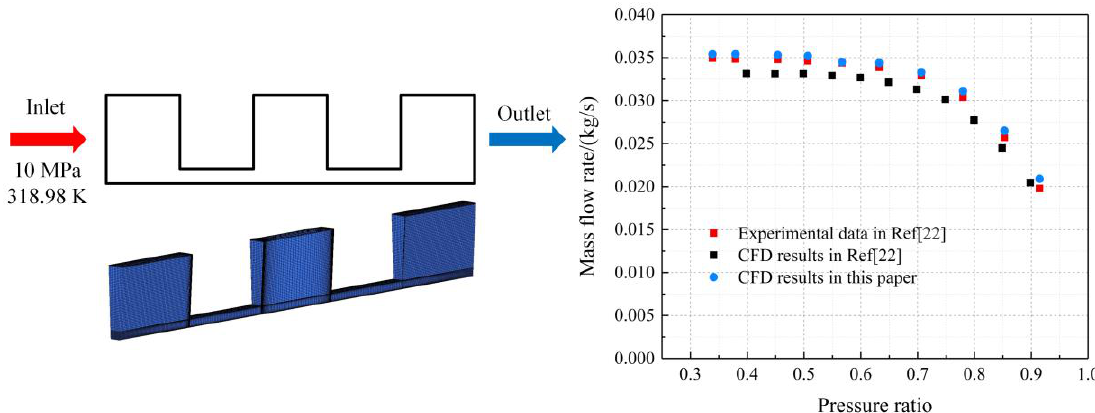
Figure 4. The geometric structure and analysis results for validation.